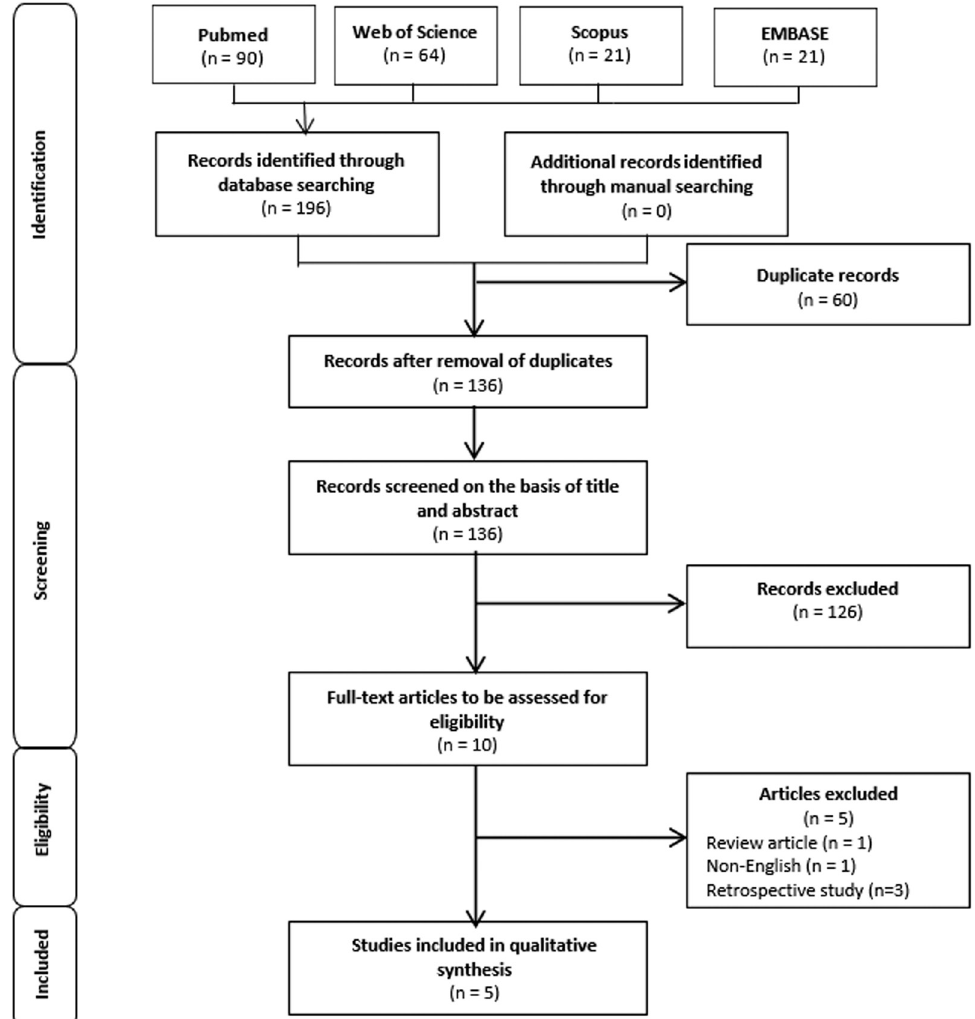
Figure 1. Flow diagram of the studies retrieved through the selection